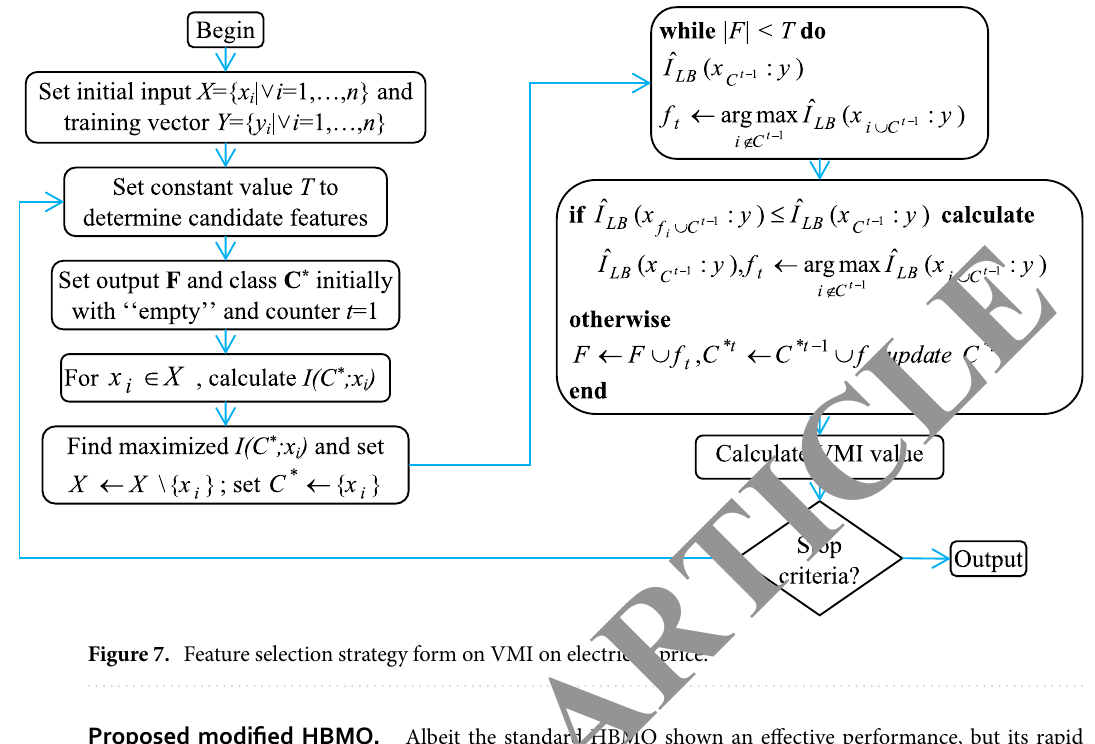
Figure 7. Feature selection strategy form on VMI on electricity